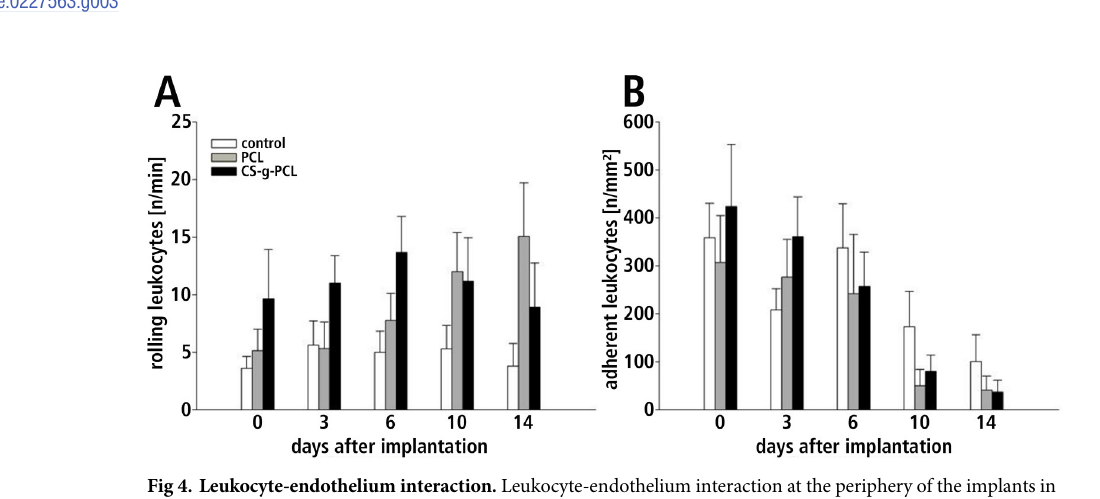
PLOS ONE | https://doi.org/10.1371/journal.pone.0227563 January 13,